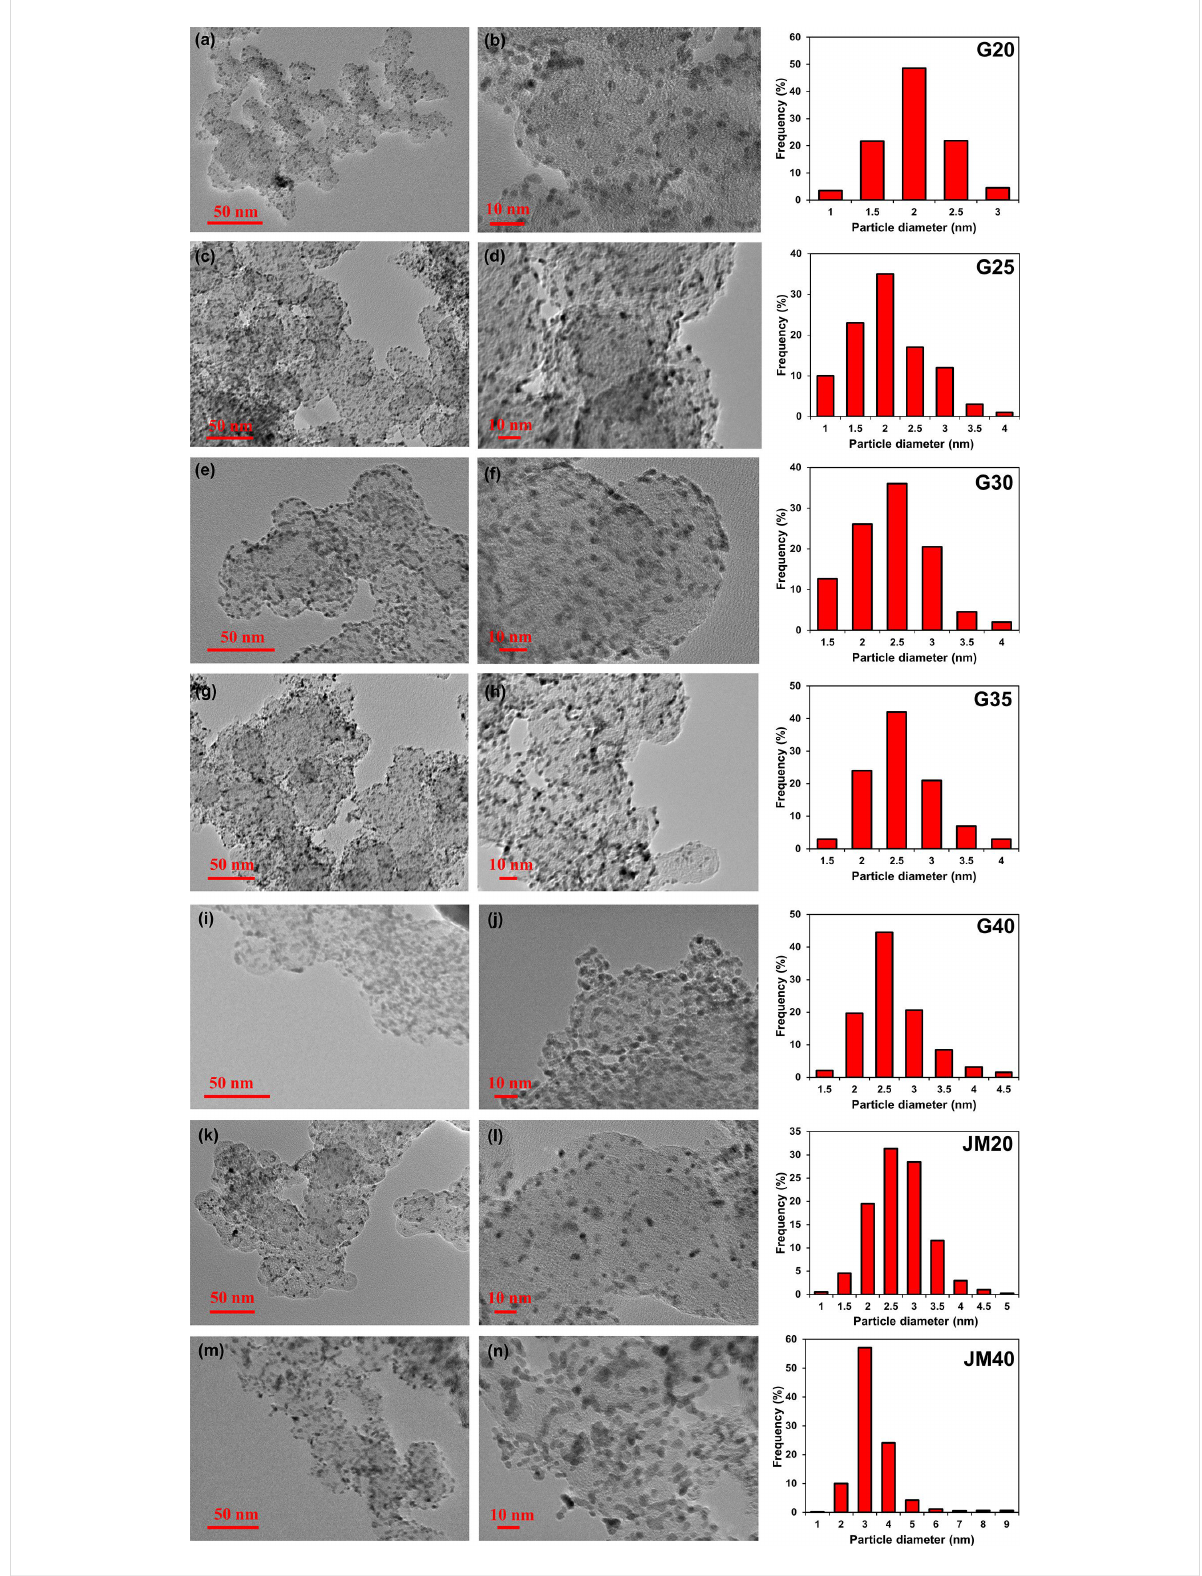
Figure 2: Micrographs of Pt/C samples of the catalysts G20 (a,b), G25 (c,d), G30 (e,f), G35 (g,h), G40 (I,j), JM20 (k,l), and JM40 (m,n), and histograms of nanoparticle size distribution in the corresponding